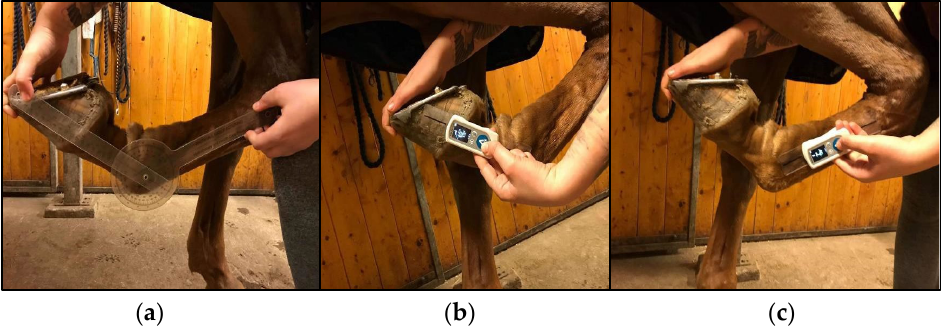
Figure 2. ( a ) Measurement of the fetlock joint with a universal goniometer. Measurement of the fetlock joint with a digital goniometer for the ( b ) start and ( c ) end positions (photo: Nicole Gandre Lauridsen).